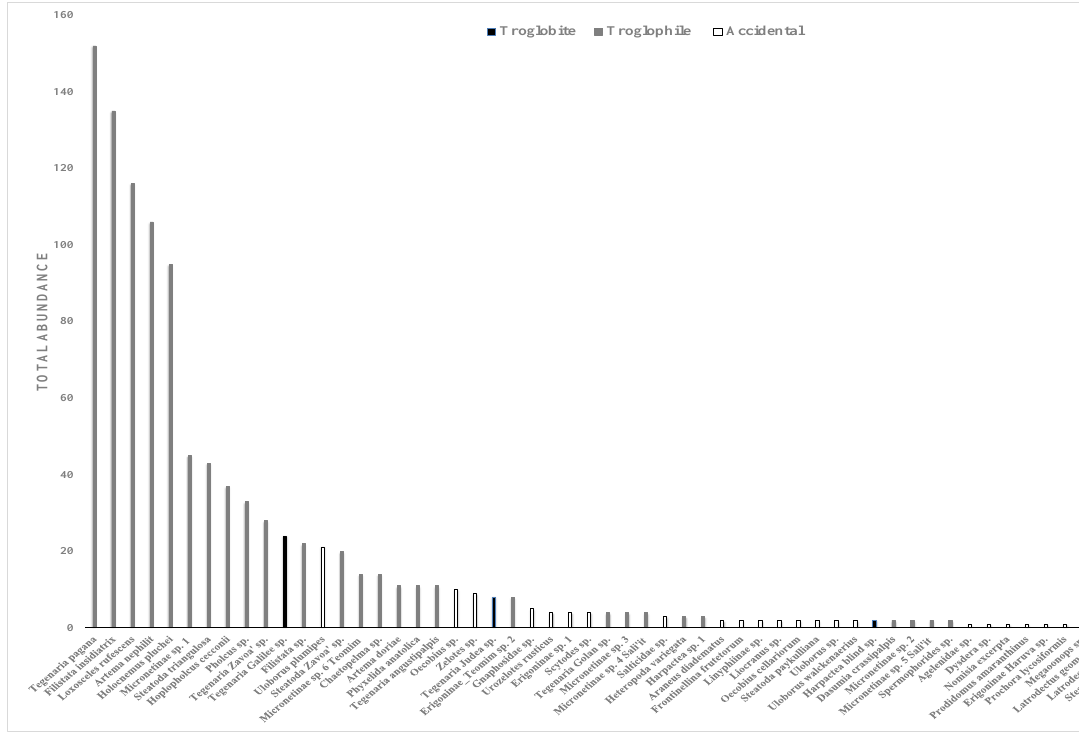
Figure 4. Rank-abundance graph of 62 spider species from 34 Levantine caves (‘Ammude ‘Amram small cave (34) had no observed spiders during our two visits).